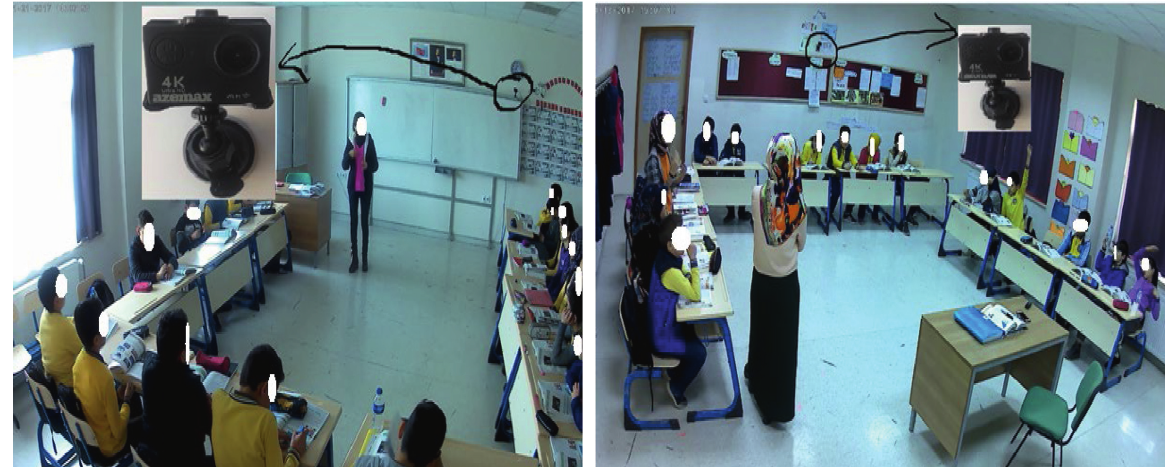
Figure 2: Placement of the